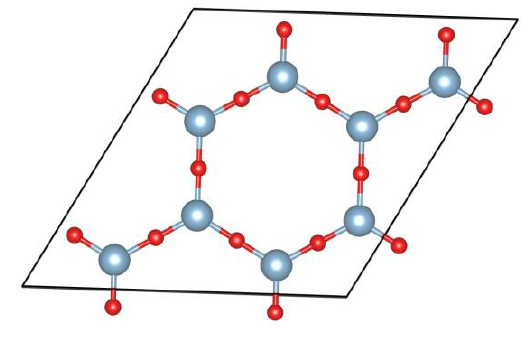
Fig. 1. Optimized ground state geometry of Al